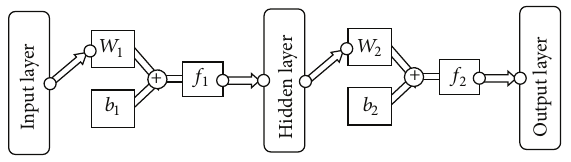
Figure 6: Flow chart of BP neural